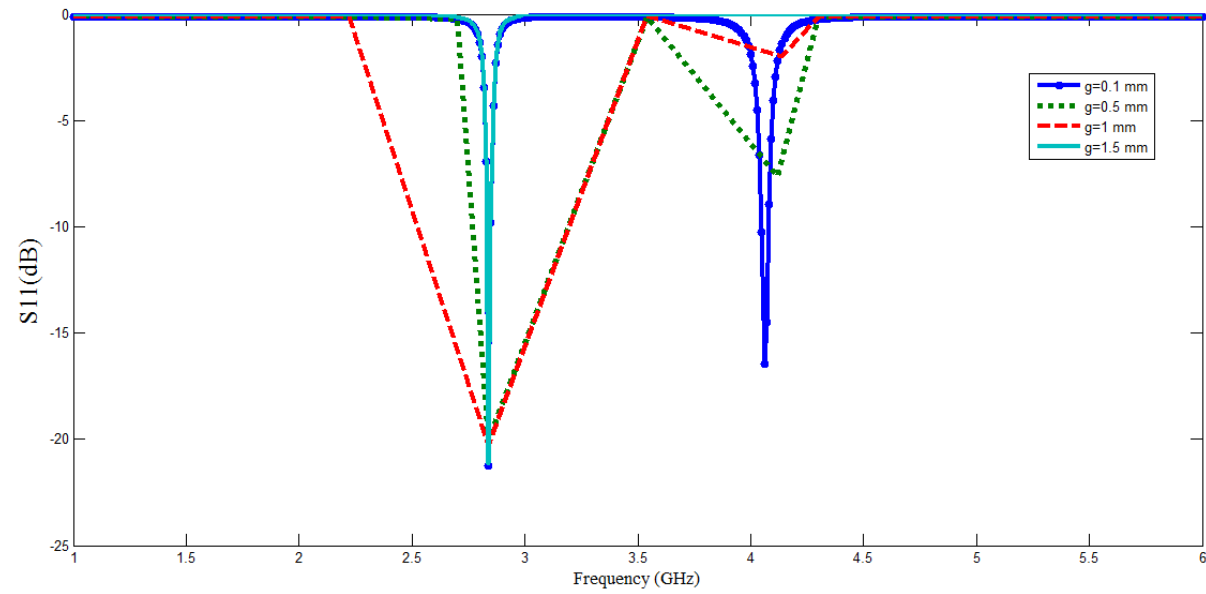
Figure 9. Simulated S11 responses for the projected diplexer based on the coupling space (g).